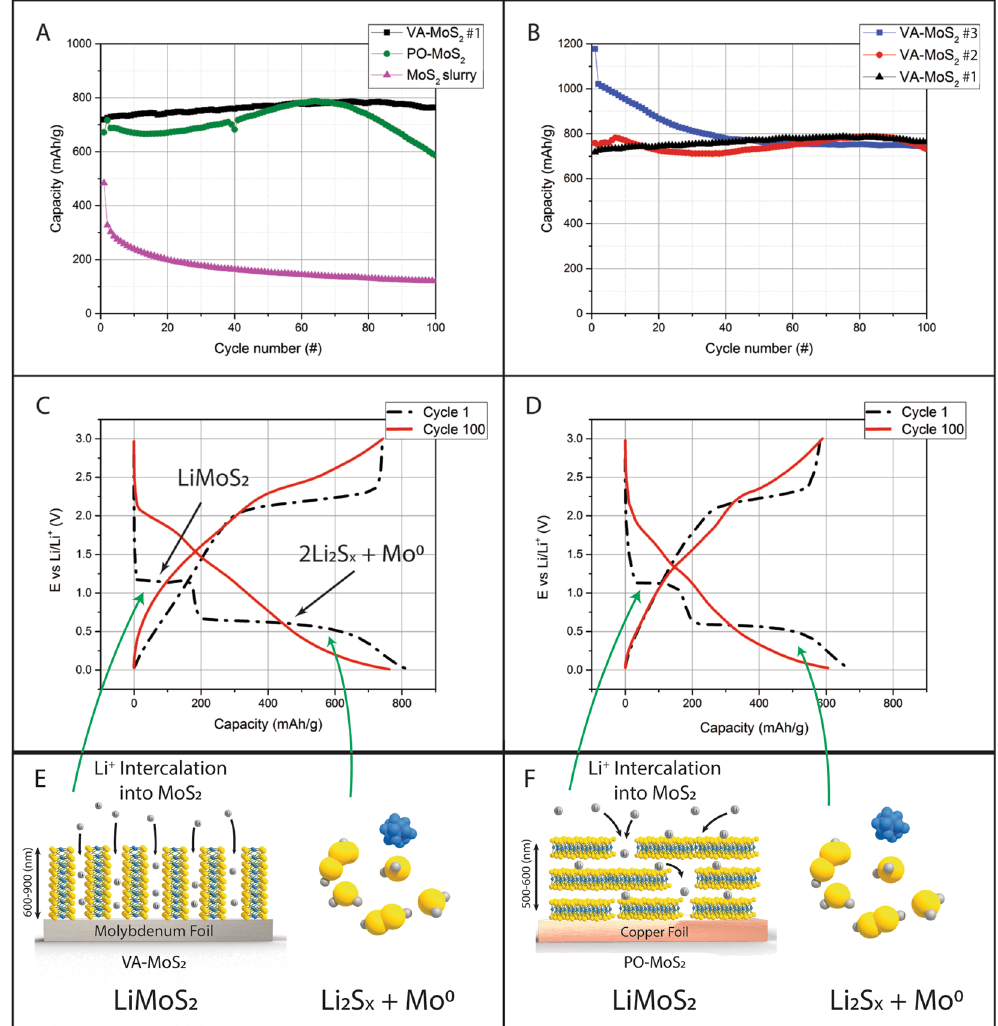
Figure 7. Specific capacity from galvanostatic measurements at a C/3 rate of VA-MoS 2 #1, PO-MoS 2 and slurry electrodes ( A ); Specific capacity at a C/3 rate of VA-MoS 2 #1 (black triangle), VA-MoS 2 #2 (red dots) and VA- MoS 2 #3 (blue squares); voltage profile of cycle 1 (black dotted line) and cycle 100 (red plain line) for VA-MoS 2 #1 ( C ) and PO-MoS 2 ( D ); lithiation mechanism in VA-MoS 2 ( E ) and PO-MoS 2 ( F